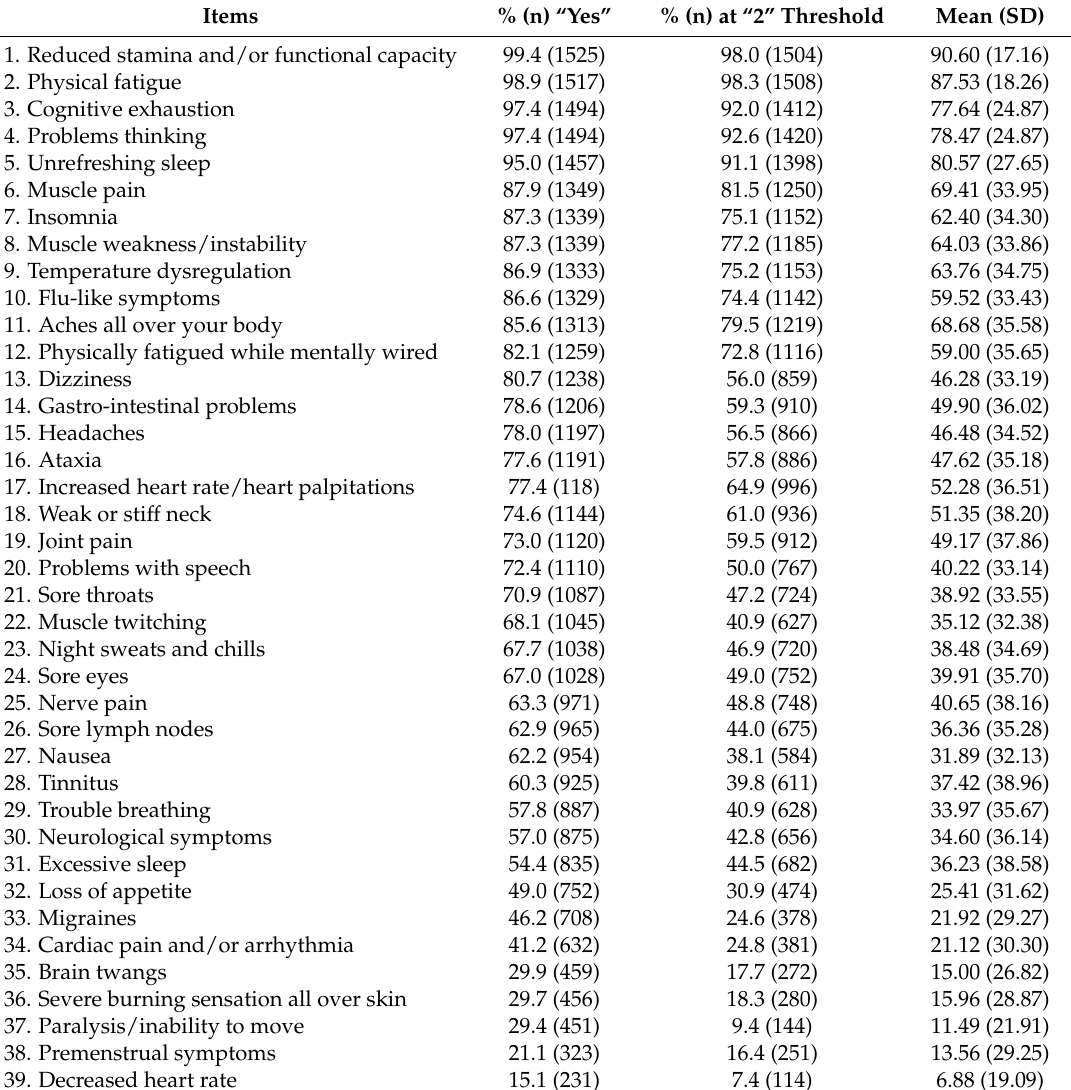
Table 4. Symptoms made worse due to physical or cognitive exertion ( N =